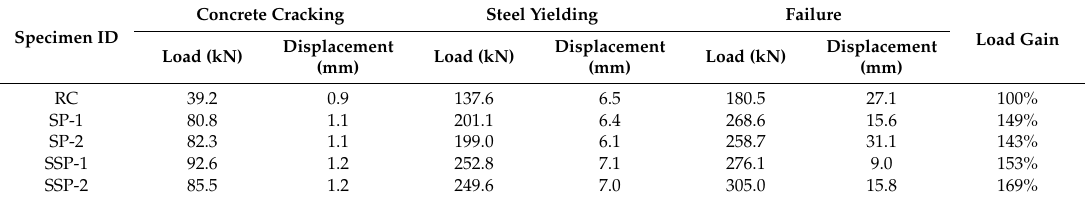
Table 5. Test results of failure test for TRC panel strengthened slab specimens.